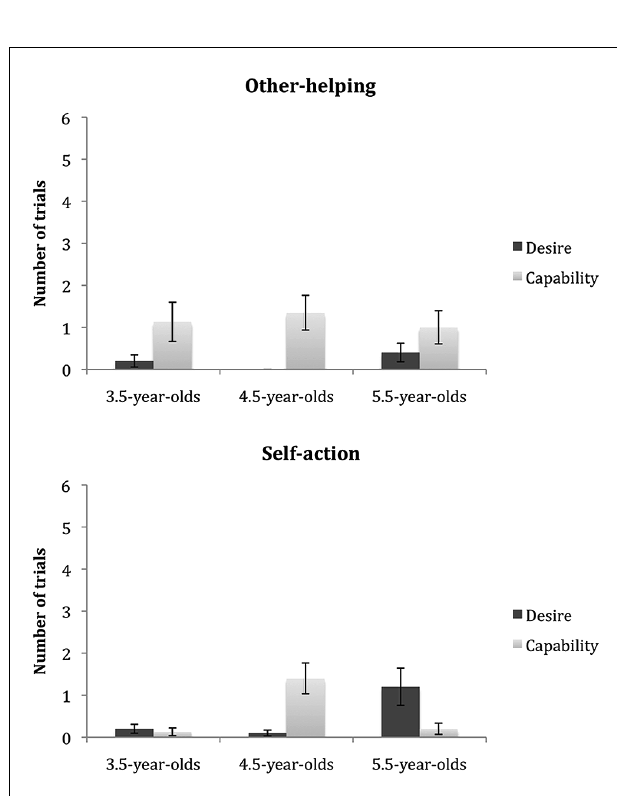
FIGURE 3 |The number of trials in which children’s justification fell to each category as a function of age groups and response types. The error bars indicate standard